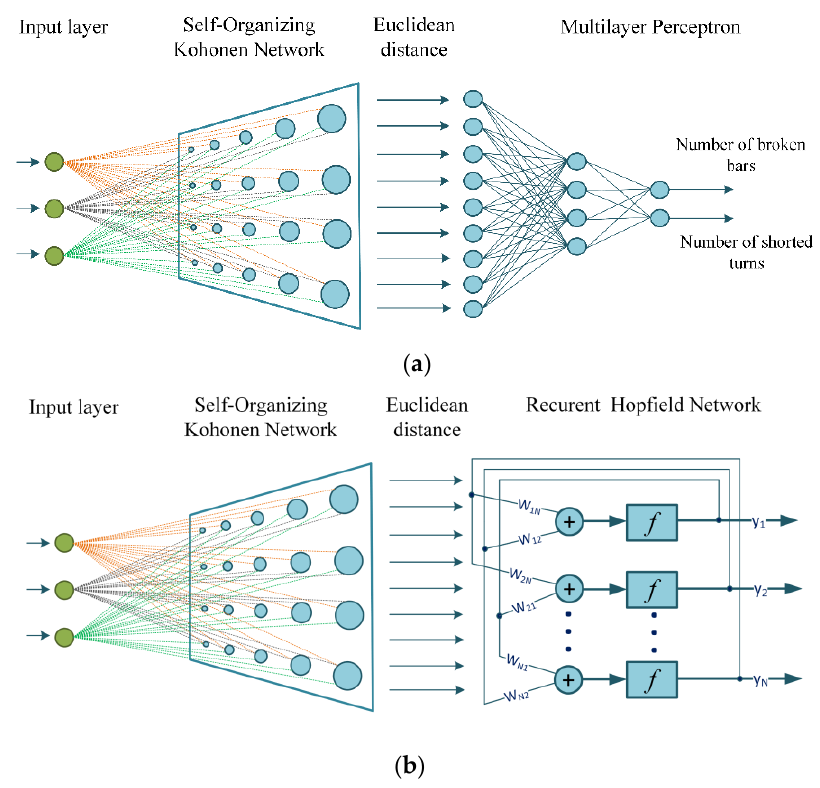
Figure 4. Structures of the proposed cascaded neural networks: ( a ) SOM–MLP, ( b ) SOM–RHN.